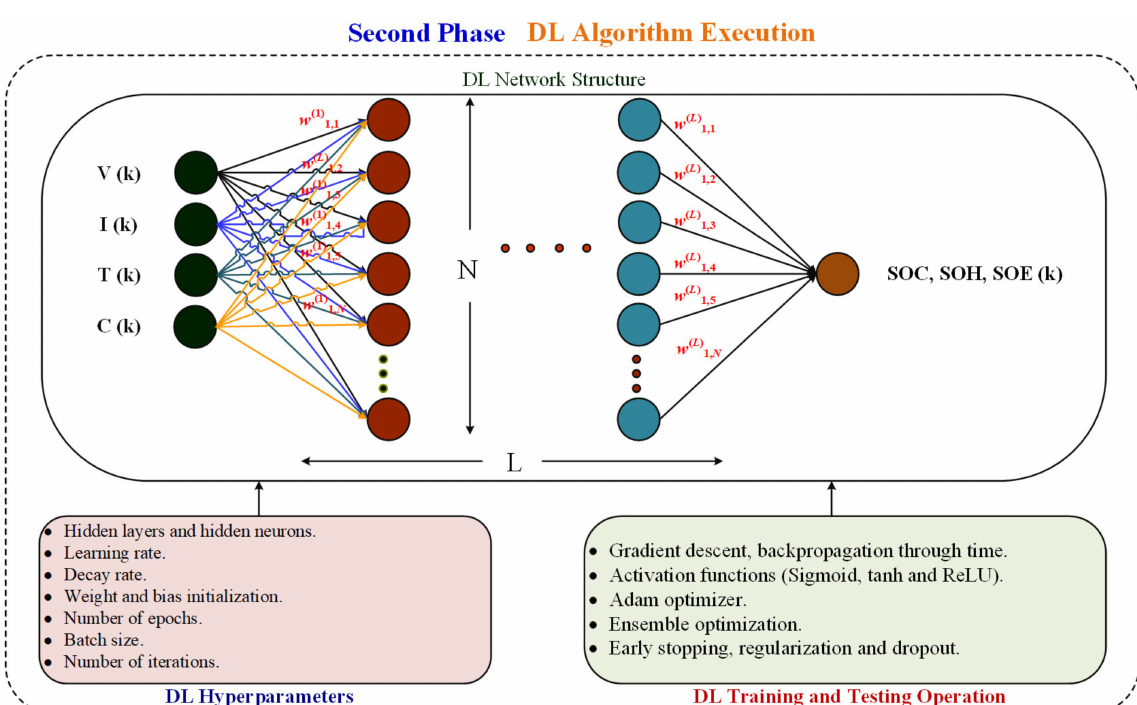
Figure 3. DL algorithm structure, execution, hyperparameters, and